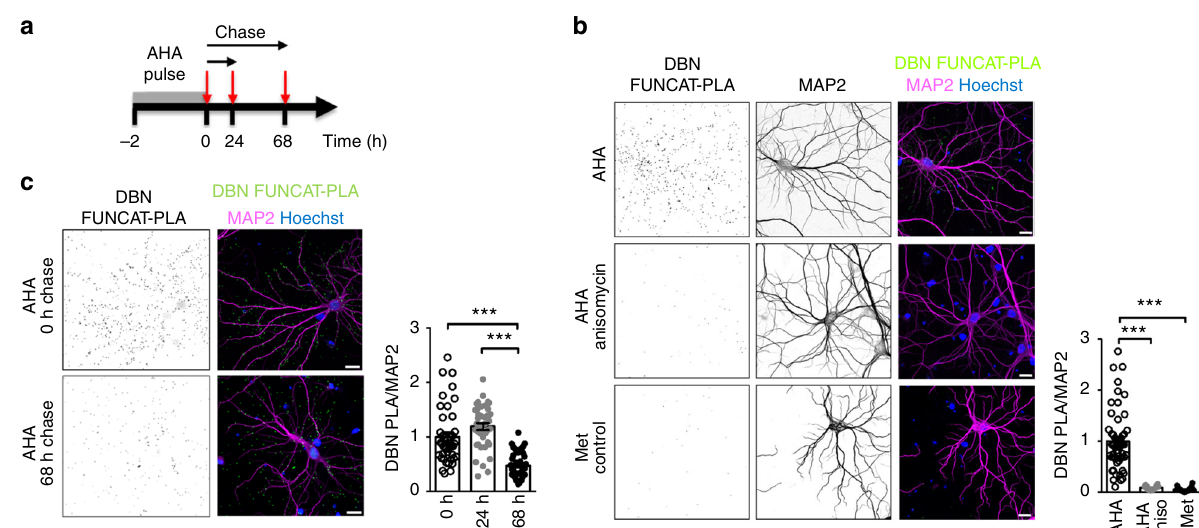
Fig. 3 Visualization of endogenous DBN turnover in neurons using FUNCAT-PLA. a Schematic experimental protocol. Hippocampal neurons were incubated with AHA, and chased with AHA-free medium before performing FUNCAT click chemistry. Immunostaining of DBN and subsequent proximity ligation assay (PLA) performed in situ allow visualization of newly synthesized DBN. b Veri fi cation of the FUNCAT-PLA experimental protocol. Fluorescent newly synthesized DBN (FUNCAT-PLA in magenta) in the presence of AHA alone (AHA), AHA and anisomycin (AHA-anisomycin) or methionine alone (Met control). Quanti fi cation of the ratio of the FUNCAT-PLA signal over the cell volume marker area (MAP2), relative to AHA-treated neurons is as shown. AHA: n = 53, N = 5; AHA-anisomycin: n = 14, N = 3; Met control: n = 32, N = 5. c Newly synthesized DBN after 2 h pulse with AHA (0 h chase) followed by 24 h chase or 68 h chase. Quanti fi cation of the ratio of FUNCAT-PLA signal over cell volume marker area (MAP2), relative to the time-point ‘ chase 0 h ’ is as shown. 0 h chase: n = 42, N = 3; 24 h chase: n = 40, N = 3; 68 h chase: n = 44, N = 3. All bar graphs are represented as mean ± SEM. Statistics were performed using one-way ANOVA Bonferroni test. *** p < 0.001. N = number of biologically independent experiments, n = total number of neurons. DBN developmentally regulated brain protein, ANOVA analysis of